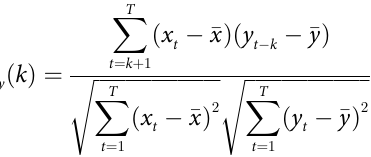
ffiffiffiffiffiffiffiffiffiffiffiffiffiffiffiffiffiffiffiffiffiffiffiffiffi X T